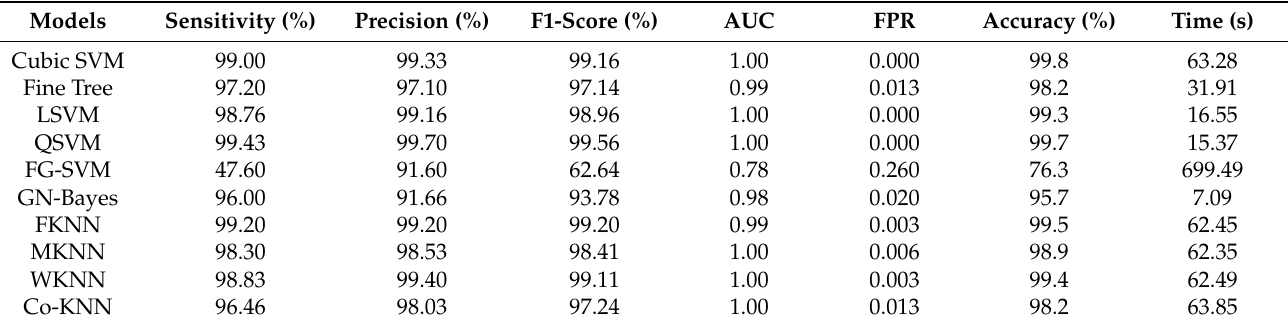
Table 13. Classification results using MEWOA on Fusion deep features for MIAS.